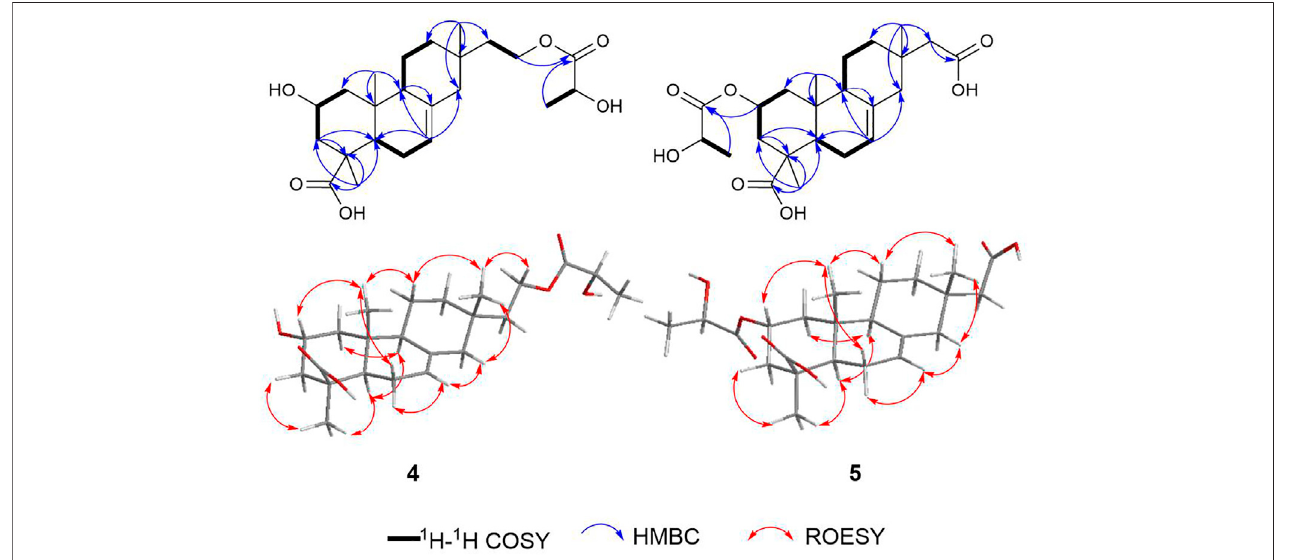
FIGURE 6 | Key 2D NMR correlations of compound 4 and 5